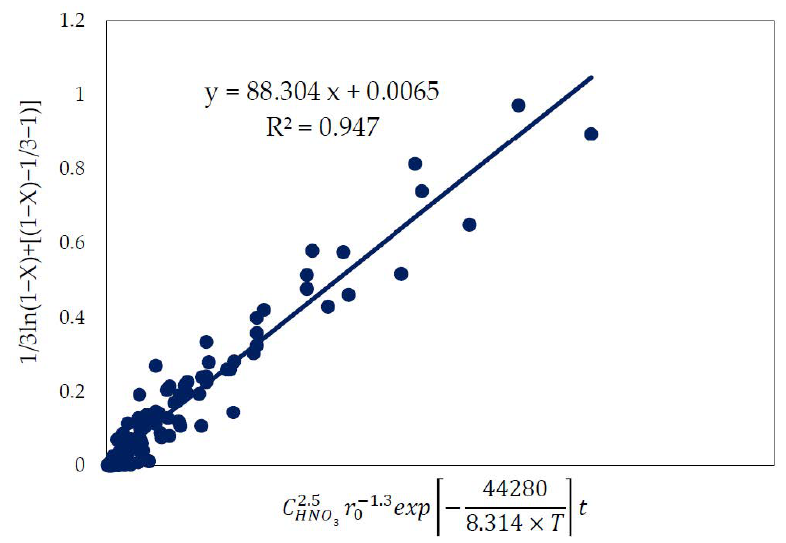
Figure 14. Relation of the applied kinetic equation and the acquired semiempirical expression .